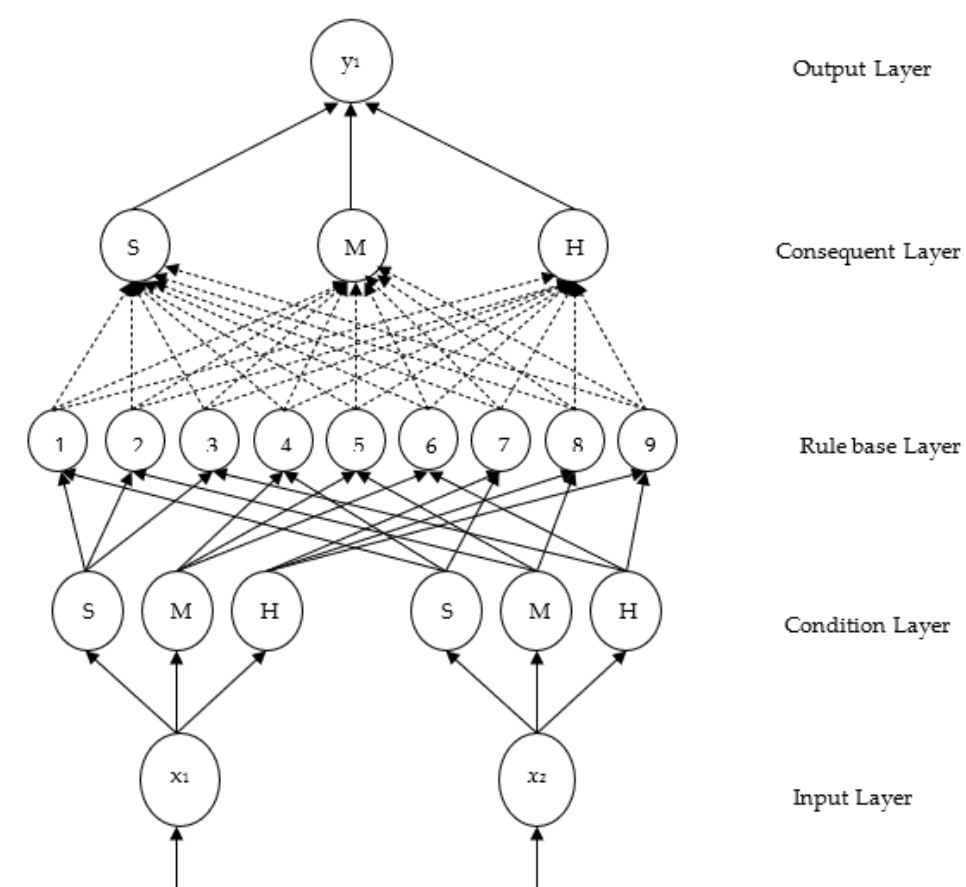
Figure 7. Schematic structure of POP-FNN for two inputs—one output scenario using three fuzzy labels of low (L), medium (M), and high (H). Table 2. Sample extracted rules from POP-FNN and ANFIS rainfall – runoff models for two rainfall inputs and flow as output when two fuzzy labels of low (L) and high (H) are chosen.